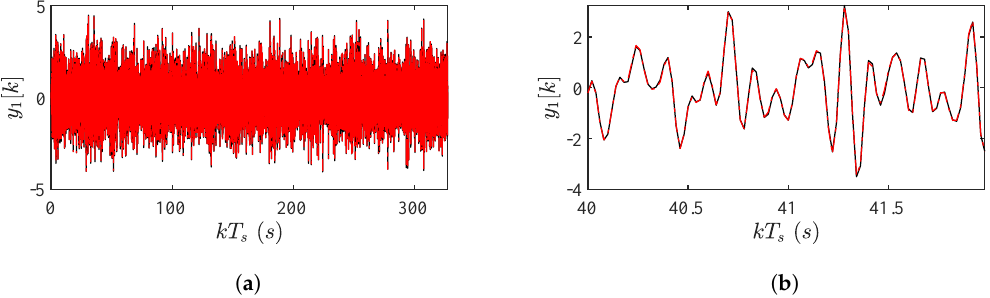
Figure 13. Spring-mass-damper: actual (black curves) and predicted (dashed red curves) time-series corresponding to the RGA time-series of Figure 12d: ( a ) total time span. ( b ) ≈ 2 s